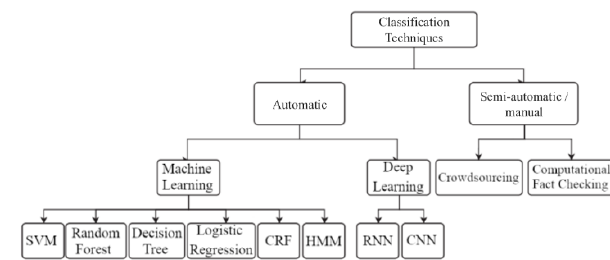
Table 1. Research Protocol. Source: The